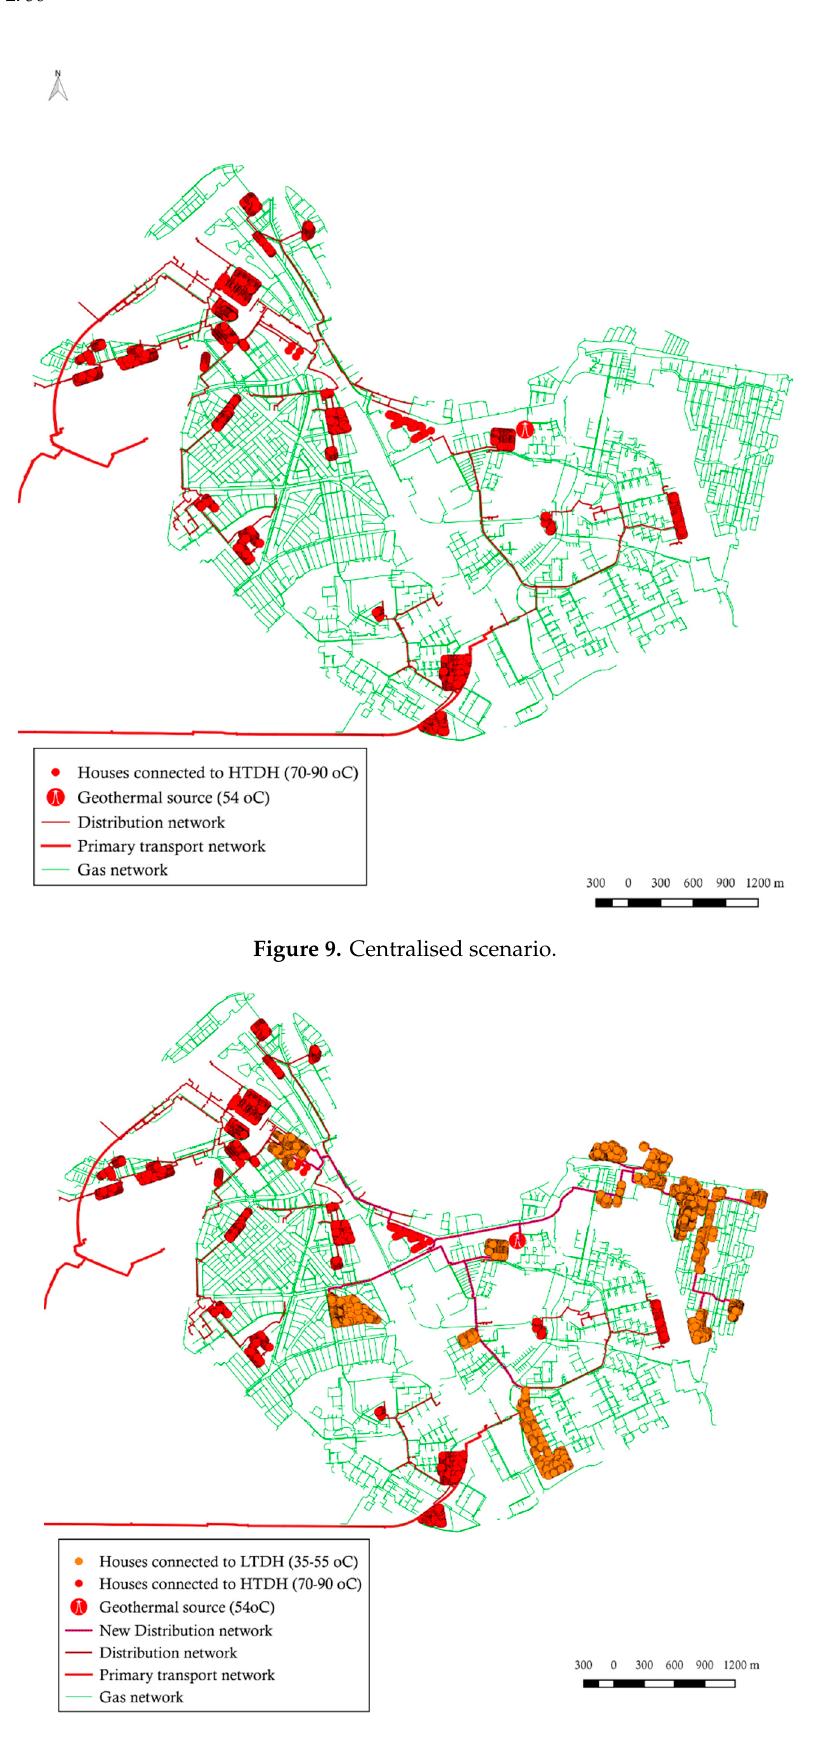
Figure 10. Decentralised Figure 3 . Decentralised scenario.